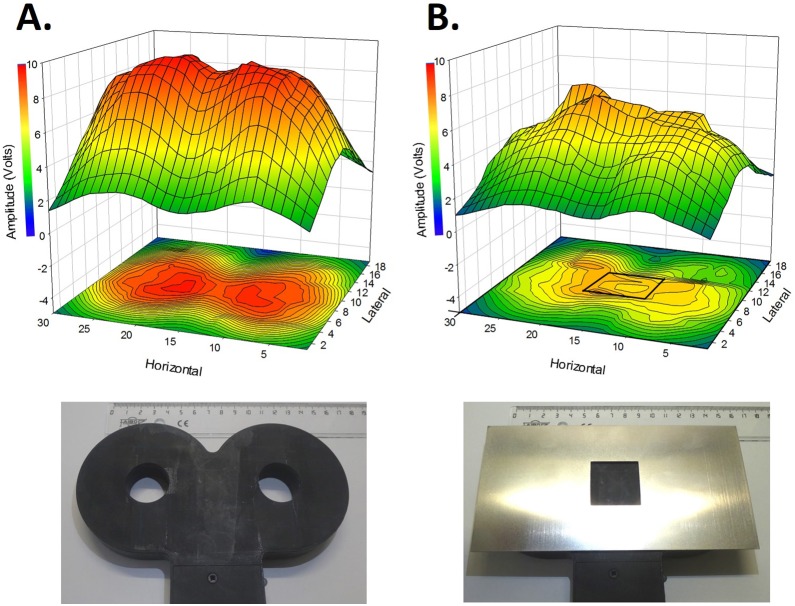
Effect of magnetic shield on the induced magnetic field intensity from the TMS coil.A) 3D representation and its 2D projection (bottom of the graph) of the whole magnetic field intensity (represented as intensity colors) recorded in volts with the solenoid from the “Unshielded” TMS coil. Picture at the bottom represents the coil. B) 3D representation and its 2D projection (bottom of the graph) of the whole magnetic field intensity (represented as intensity colors) recorded with the shield on the TMS coil (Noted as “Shielded”). Picture at the bottom represents the coil with the shield on it with the 30×30 mm window. Note that black square in the 2D projection representing the 3×3 cm window. The intensity is statistically reduced by 32% (p<0.001) compared to the one obtained in the “Unshielded” coil, and better concentrated where the rat head will be placed on (Middle of the window). Horizontal and Lateral scale represent the side of the coil, which each measured point represents half centimeter.